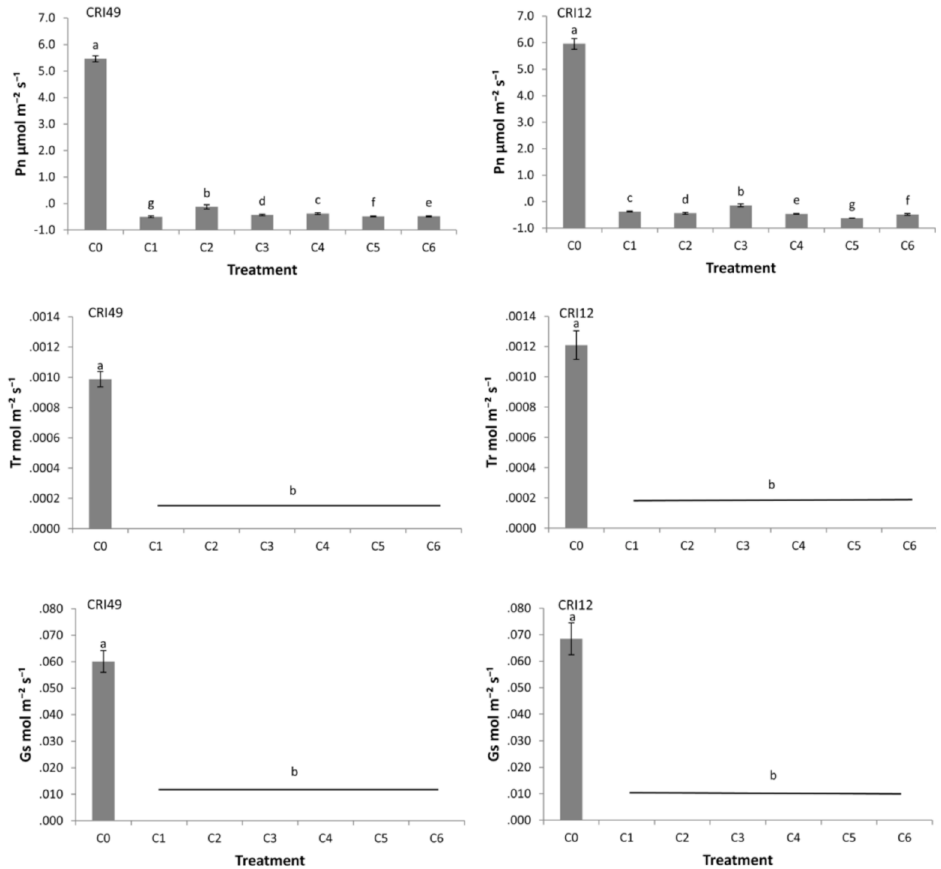
Figure 5. Effects of different concentration of TDZ (C0, C1, C2, C3, C4, C5 and C6: 0, 100, 200, 300, 400, 500, 1000 mg L − 1 ) on leaf photosynthetic characteristics at 1 day after treatment at the seedling stage. Pn, Tr, and Gs represent net photosynthetic rate, transpiration rate, and stomatal conductance, respectively. The different letters represent significantly different at p =